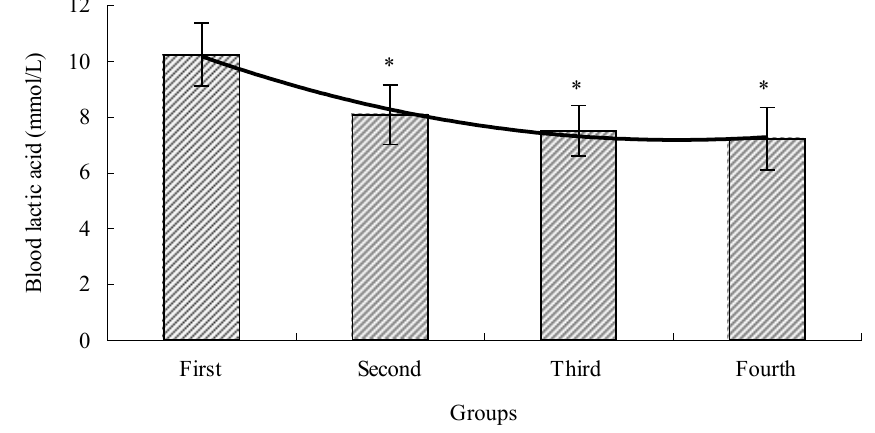
Figure 2. The effects of TBE on blood lactic acid of mice. Values are means ± SD. * P < 0.05 when compared to the control group (first